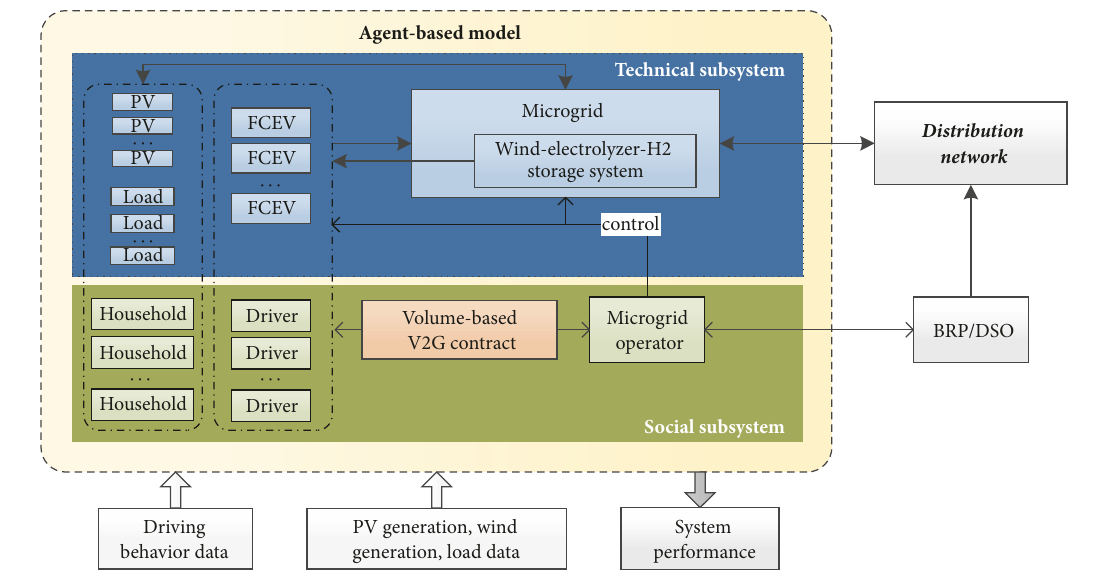
Figure 3: Agent-based model concepts: microgrid with fuel cell vehicles.